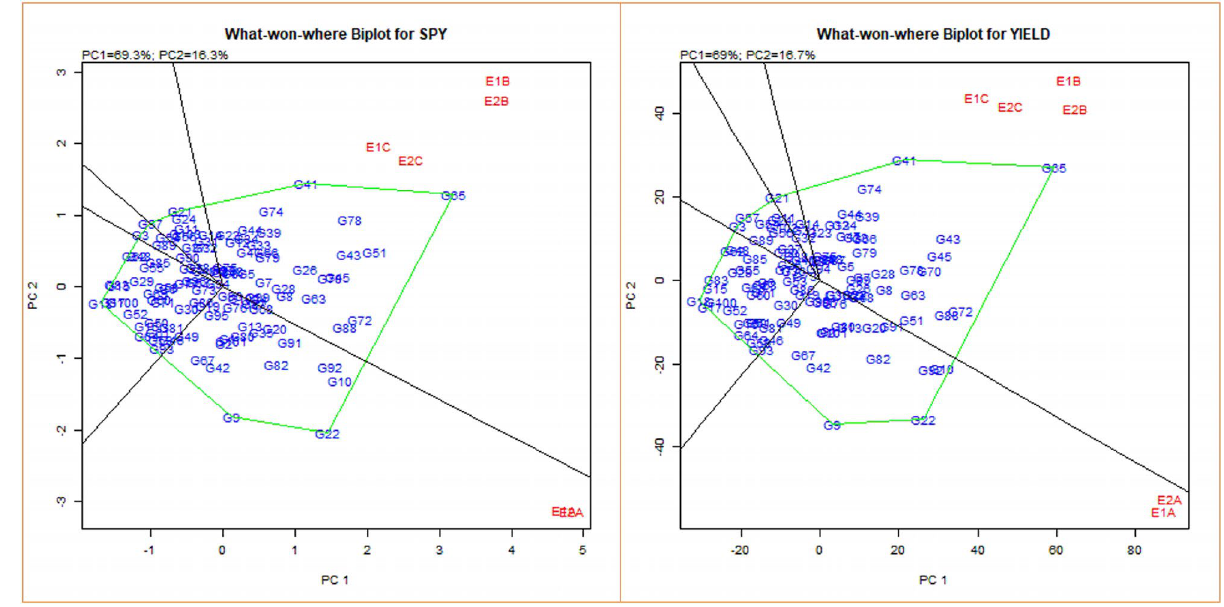
Figure 5. Polygon views of the GGE biplot based on symmetrical scaling for ‘which-won-where’ pattern of rice genotypes in six environments showing which genotype performed best in which environment (For SPY and Yield Traits).